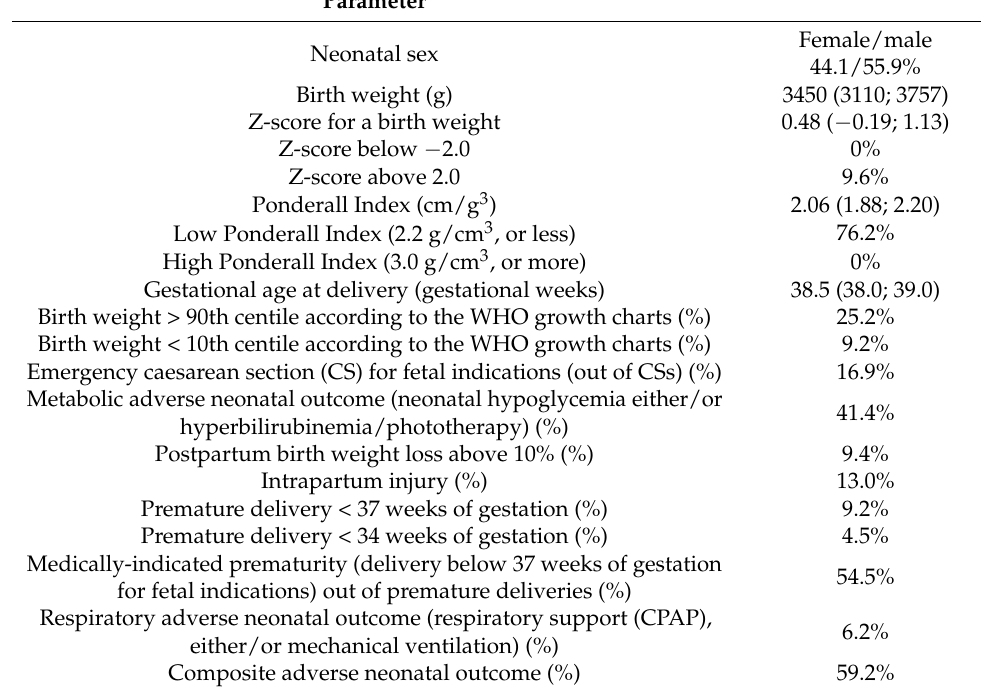
Table 2. Neonatal characteristics of the study group; data presented as median (interquartile range), or